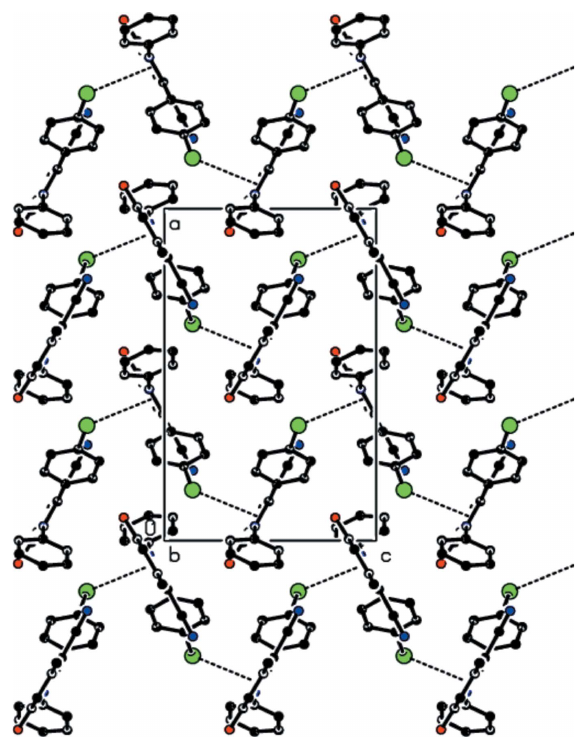
Figure 5 Packing view of the title compound along the b axis with the C—Br (cid:2)(cid:2)(cid:2) (cid:2) interactions indicated by dashed lines.